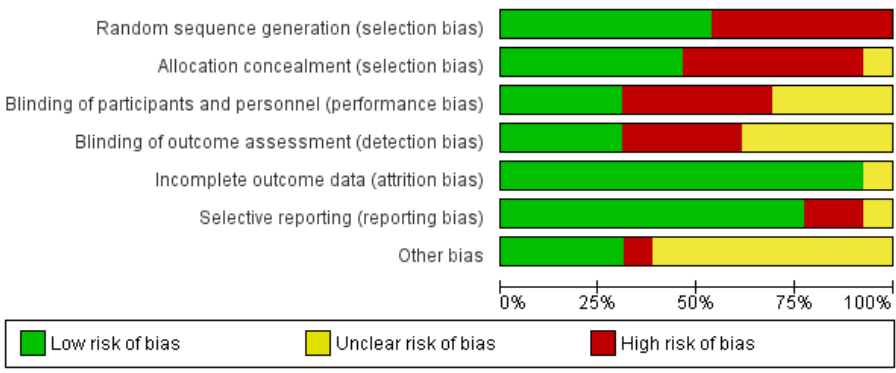
Figure 3. Risks of bias of the included studies.